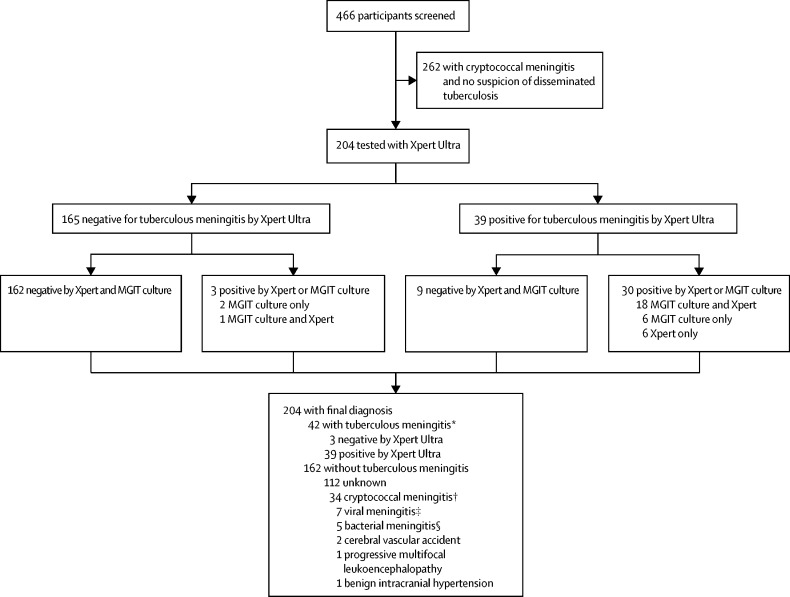
Flow diagram showing the diagnostic outcomes of the study populationXpert=Xpert MTB/RIF. MGIT=mycobacterial growth indicator tube. HSV=herpes simplex virus. CSF=cerebrospinal fluid. *Five participants with confirmed tuberculous meningitis had a positive CSF cryptococcal antigen test, of whom two had culture-confirmed cryptococcal meningitis. †Culture or PCR positive. ‡Two HSV type 1, two HSV type 2, two varicella zoster virus, and one cytomegalovirus. §One confirmed Streptococcus pneumoniae on PCR, four clinical diagnosis of bacterial meningitis based on CSF picture (ie, high CSF white blood cell count with neutrophil predominance suggestive of bacterial meningitis).